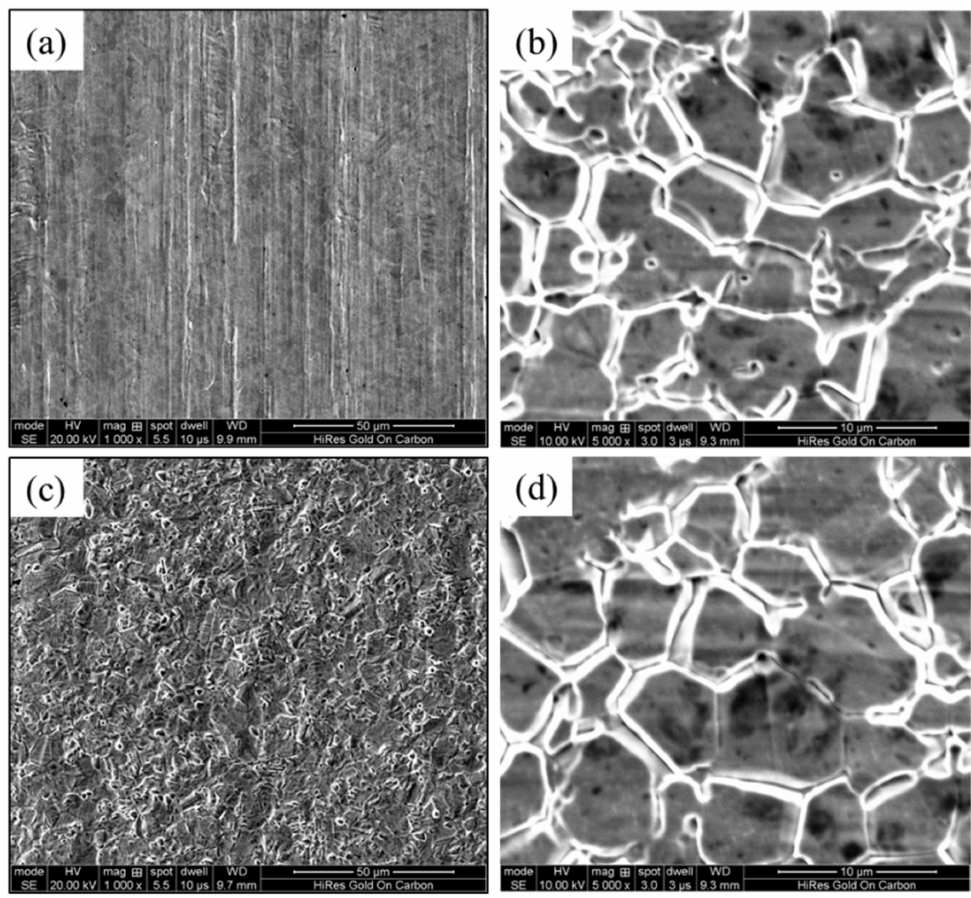
Figure 3. Surface morphology of original and treated SS316L by scanning electron microscopy (SEM). ( c ) treated SS316L before potentiodynamic tests and ( d ) treated SS316L after potentiodynamic